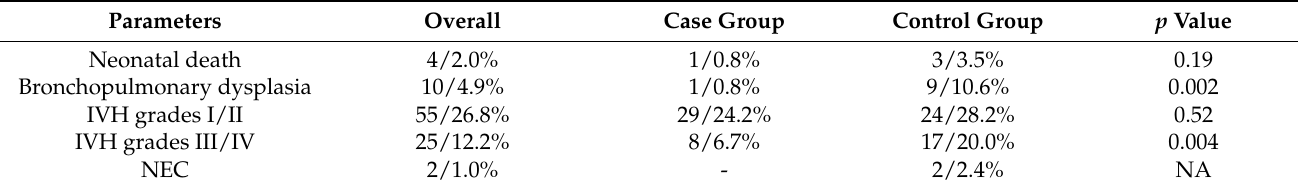
Table 3. Fetal outcomes in 205 early onset FGR